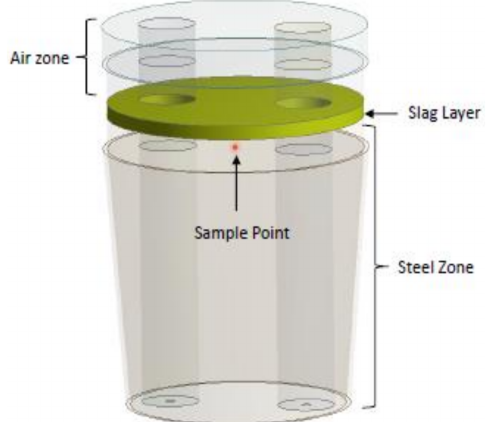
Figure 6. Sample location within steel